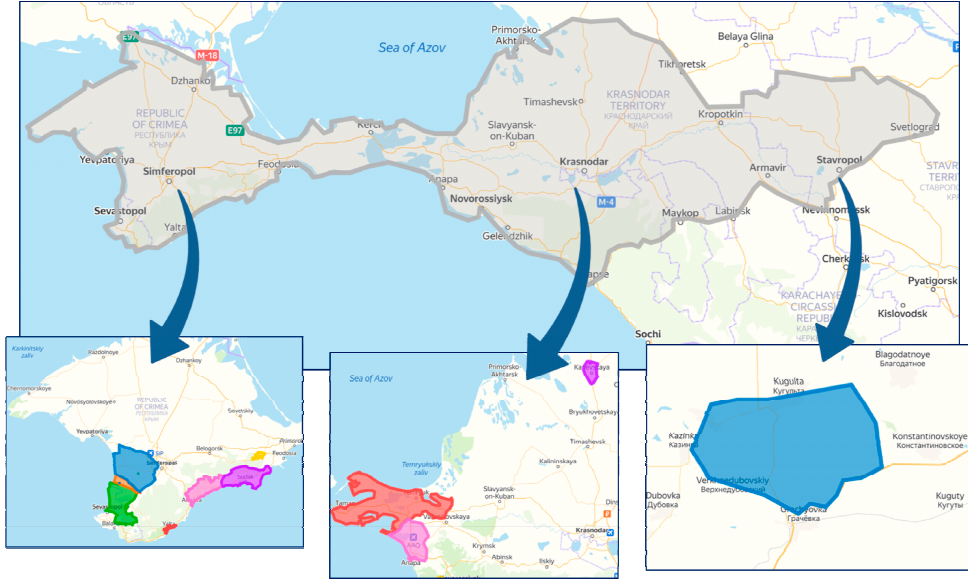
Figure 1. Viticultural zones in the south of Russia, where phytosanitary monitoring was carried